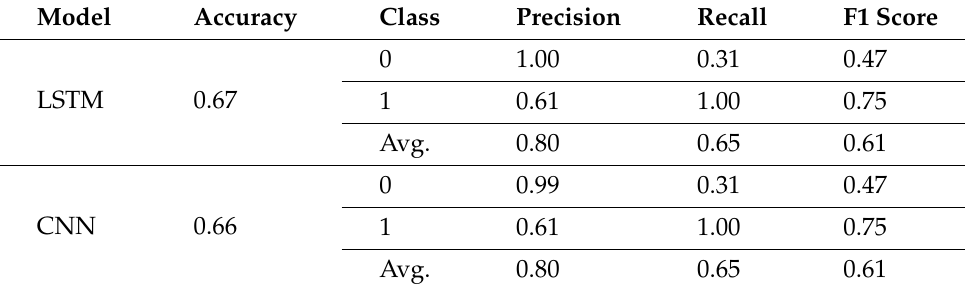
Table 16. Results of deep learning